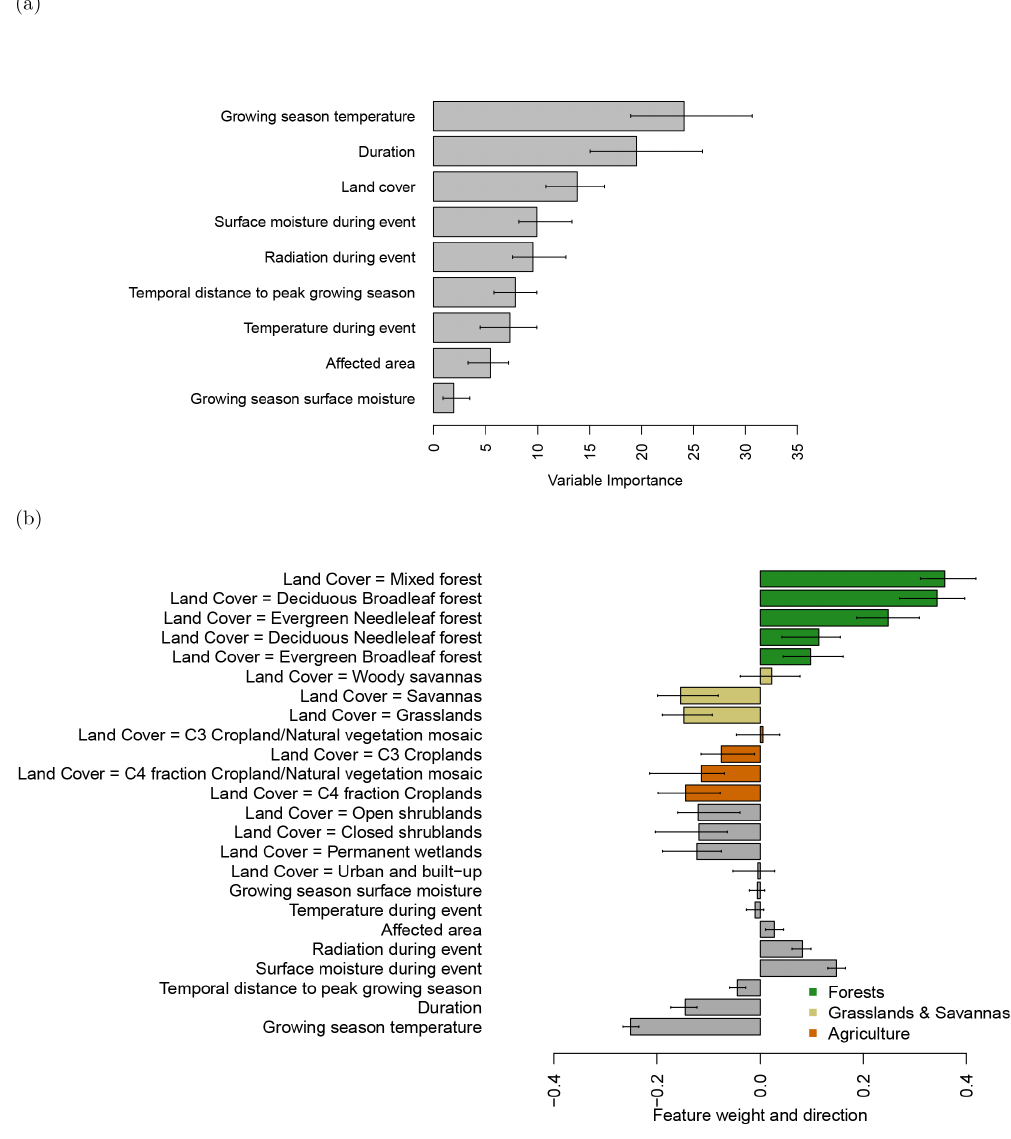
Figure 5. (a) Variable importance of the 10 best gradient boosting machines predicting average GPP anomalies during the events; (b) direction and feature weight of the variables explaining GPP anomalies of the individual events based on linear regression via local interpretable model-agnostic explanations